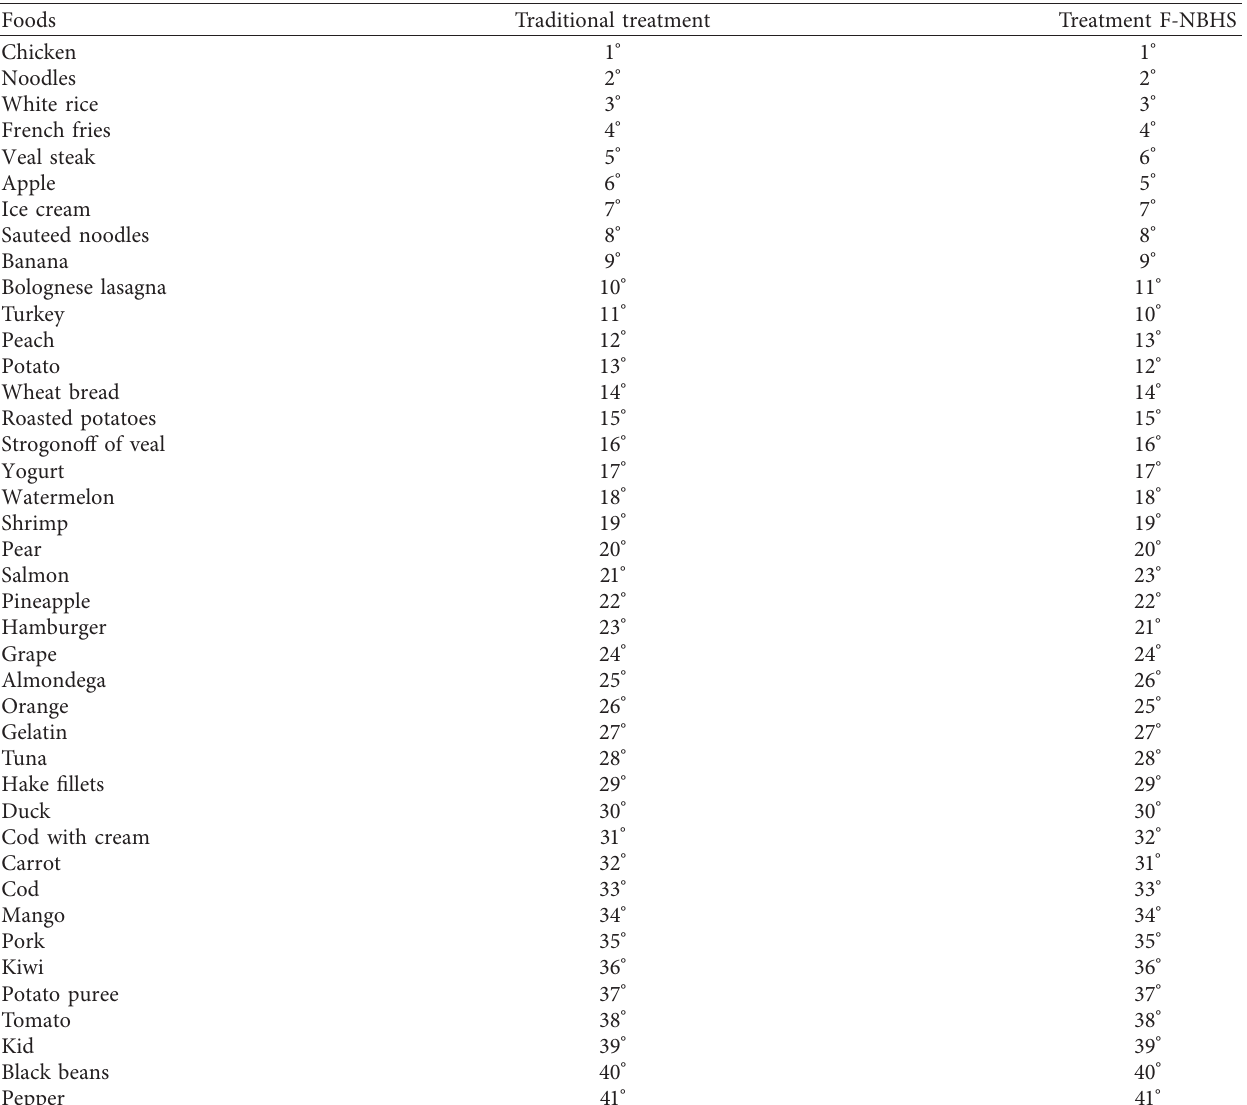
Table 9: Ranking of food preferences for all foods analyzed according to each scale